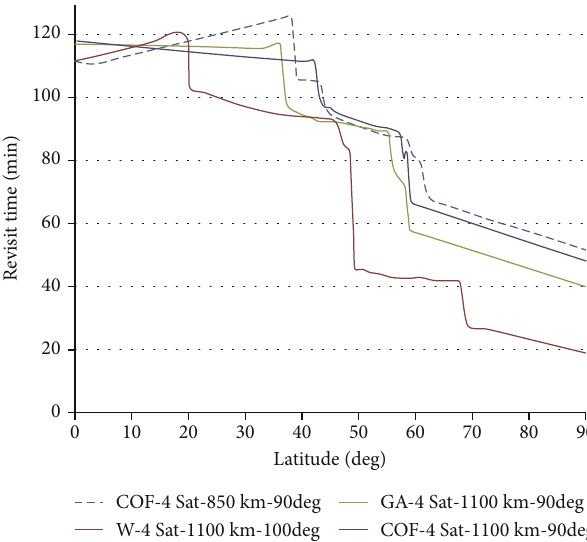
Figure 15: Compare MRT variations for 4 satellite constellations.